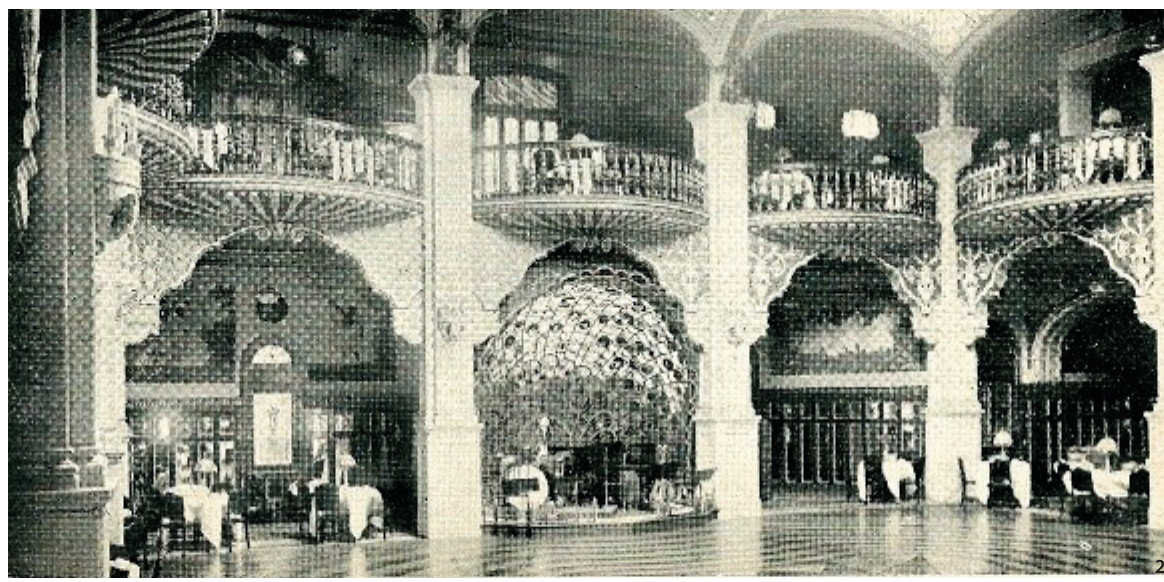
Figure 2 Astor House ballroom (Source: 1932 guidebook on